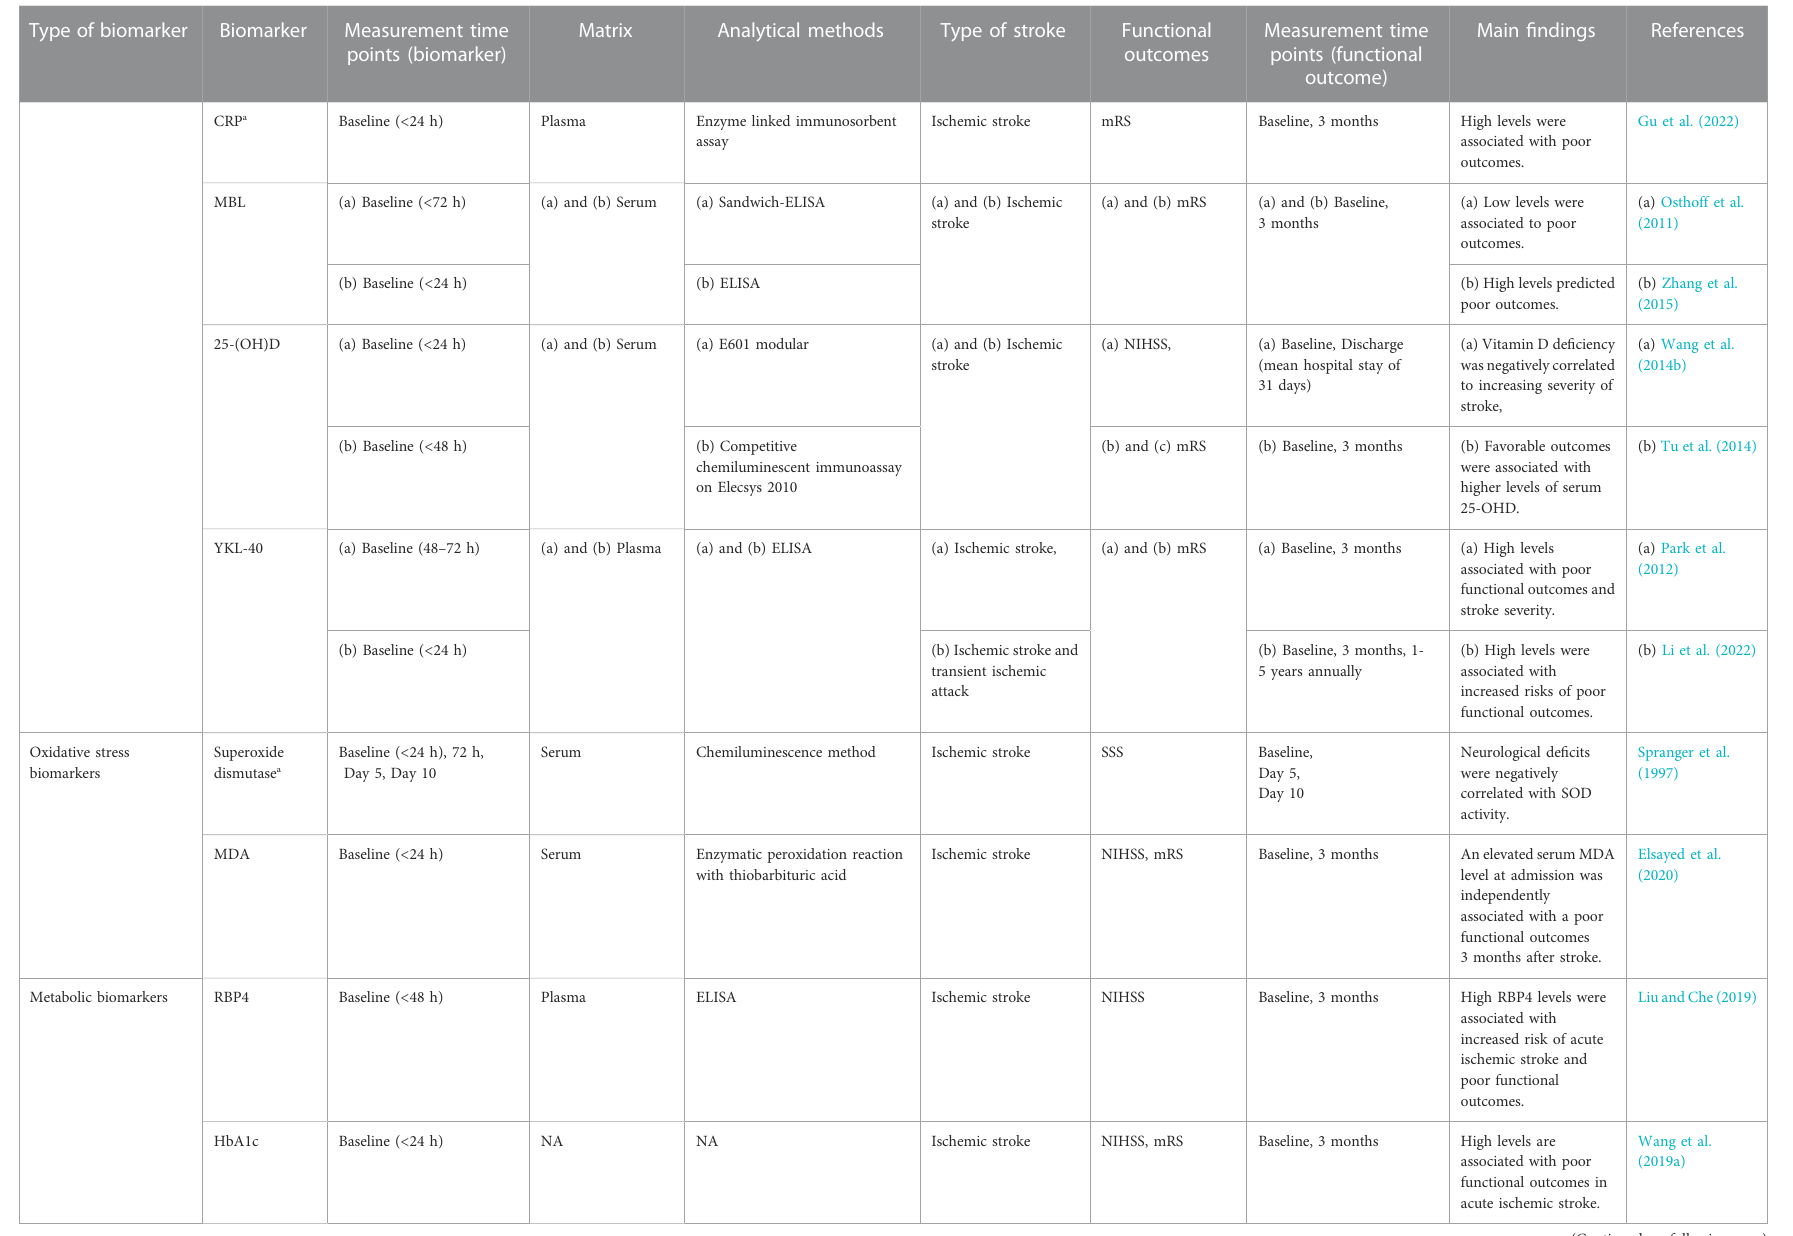
TABLE 2 ( Continued ) Molecular, genetic and epigenetic biomarkers for stroke